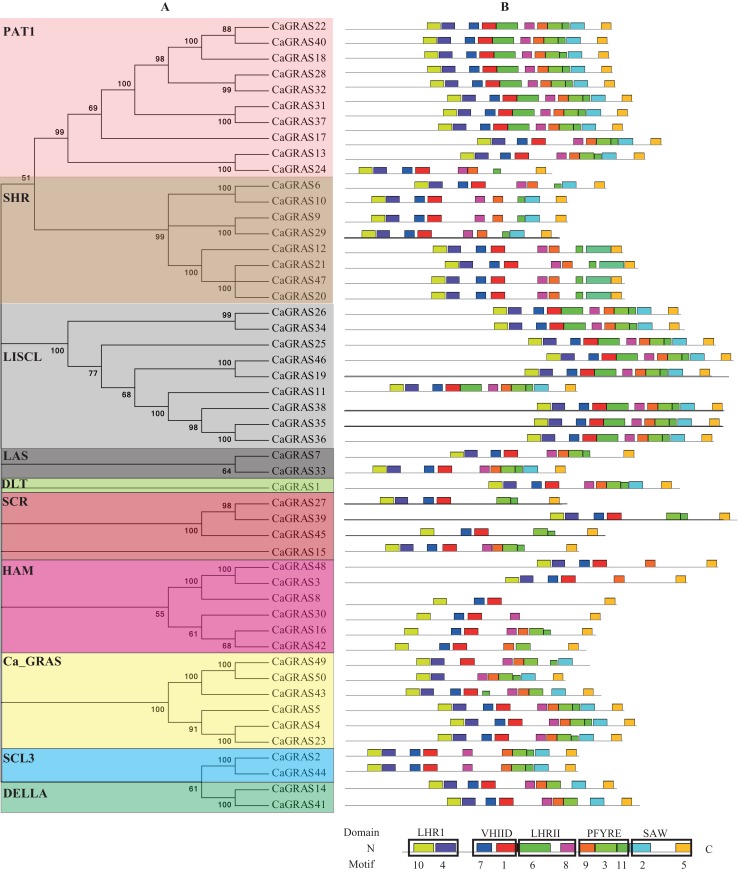
Distribution of conserved motifs in CaGRAS proteins.(A) The phylogenetic tree and their classification were depicted using the neighbor-joining method in MEGA 6.0. (B) Motif distribution in each GRAS sequence. Motif 10 and 4 is in LHRI domain at N-terminus, followed by Motif 7 and 1 in VHIID domain, Motif 6 and 8 in LHRII domain, Motif 9, 3 and 11 in PFYRE domain, and Motif 2 and 5 in SAW domain at C-terminus.